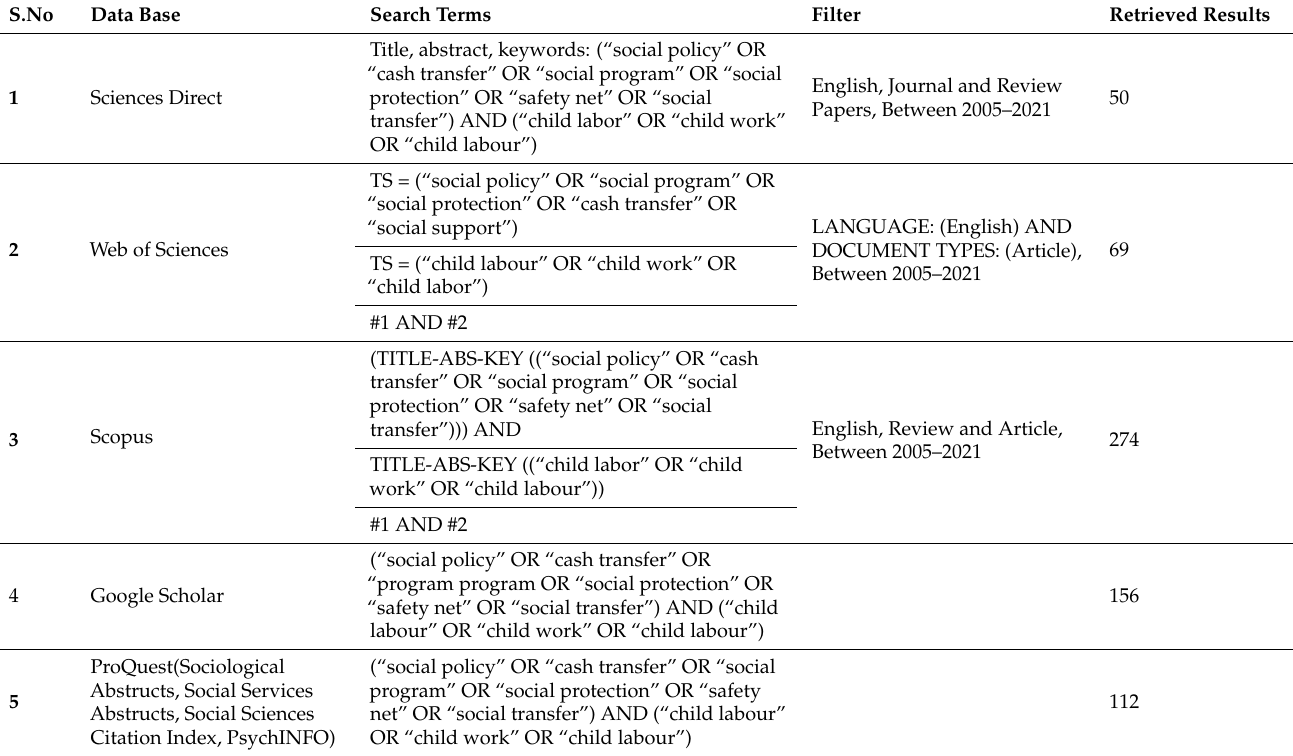
Table A1. Search Strategy and Search term combination with selected